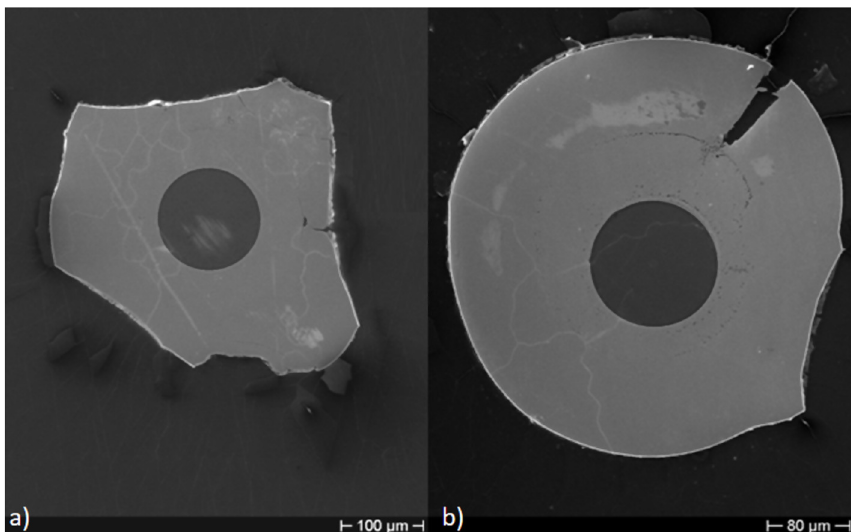
Figure 3. Cross-section of Cu–Ni samples with different Cu layer thickness after thermal cycling at